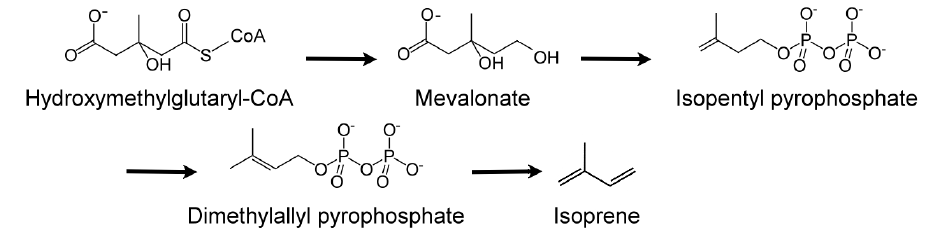
Figure 8. Mevalonate pathway for isoprene production.